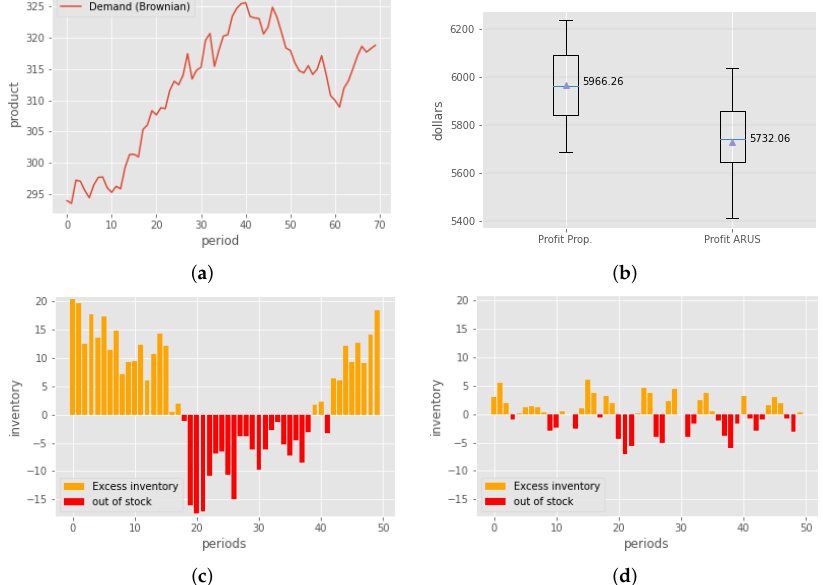
Figure 3. ( a ) Brownian motion as demand, ( b ) profit box plot of ARUS and proposed method, ( c ) ARUS inventory, and ( d ) proposed method